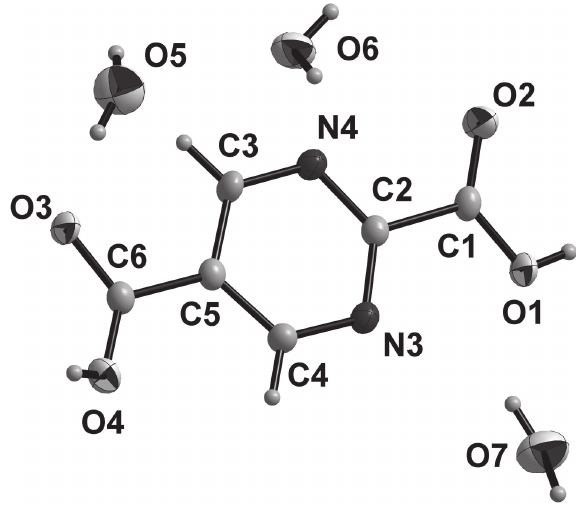
Table 1: Data collection and handling.